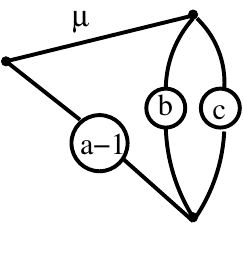
Figure 8 . A ( a ; b; c